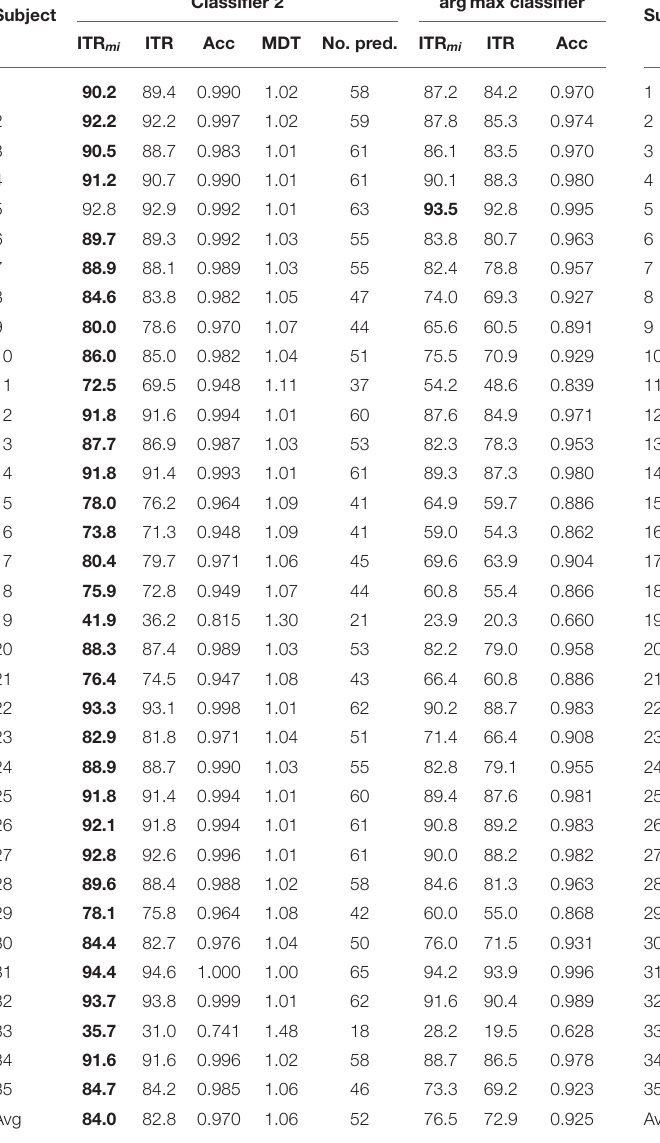
Table entries are averages over the sets of three classes of Dataset 2. Here α β 100 ,n 1 ,andt 25 ,probabilitiesareestimatedwiththeskew-normaldistribution. = = = No.pred.standsforthenumberofpredictions.Thenumberofpredictionsforthe argmax classifier is 66 and MDT is 1 s for each subject. MDT is estimated from test data, and it includes gaze shift time. Bold values correspond to the highest ITR (6) of each subject.